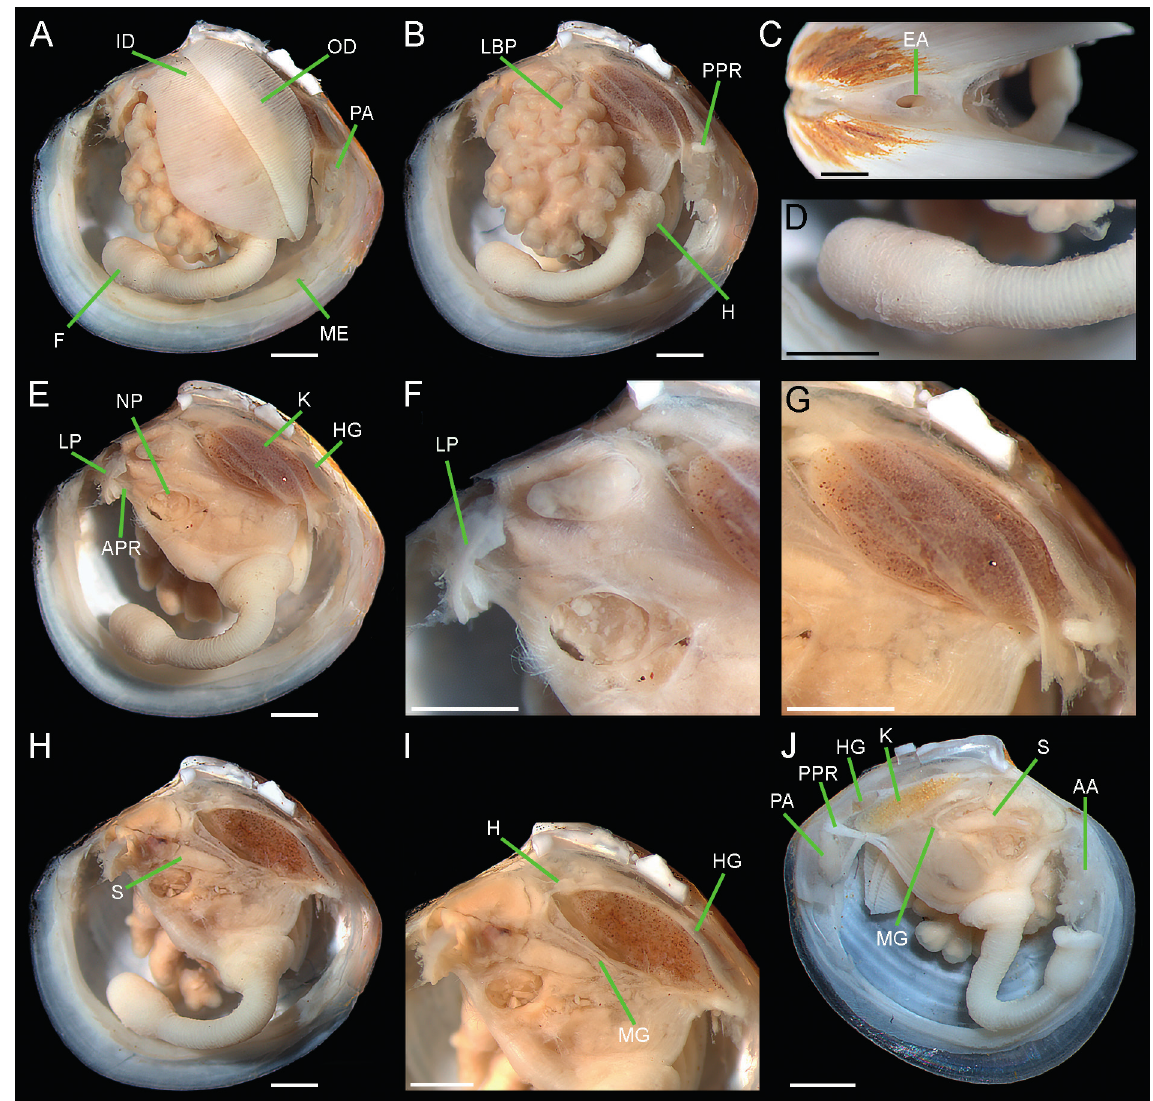
Fig. 5. Parathyasira coani sp. nov. A . Gross anatomy after removal of left valve, mantle, and anterior adductor muscle, shell length 7.5 mm (MIMB 43819). B . Gross anatomy after further removal of left ctenidium (MIMB 43819). C . Exhalant aperture (MIMB 43819). D . Bulbous portion of foot (MIMB 43819). E . Gross anatomy after further removal of left lateral body pouch (MIMB 43819). F . Labial palps (MIMB 43819). G . Kidney with granules (MIMB 43819). H–I . Digestive system (MIMB 43819). J . Gross anatomy of specimen with anterior adductor muscle after removal of right valve, mantle, right ctenidium, and right lateral body pouch, shell length 5.5 mm (MIMB 43818). Abbreviations: see Material and methods. Scale bars = 1